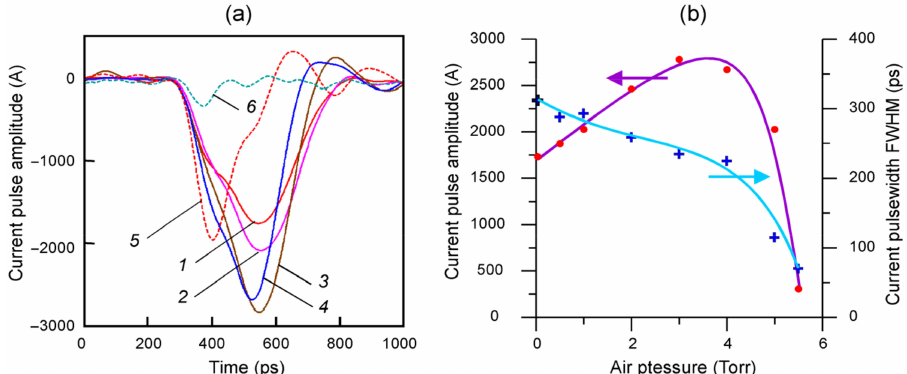
Figure 9. ( a ) Pulses of the electron beam current from collector probe at different air pressures in the MICD: 1—3 × 10 − 2 Torr; 2—1 Torr; 3—3 Torr; 4—4 Torr; 5—5 Torr; 6—5.5 Torr. Other parameters: graphite cathode; D = 10 mm; collector has diameter of 25 mm; B = 2.1 T. ( b ) The dependence of the amplitude (modulo) and duration (FWHM) of the beam current pulse in the pressure range.